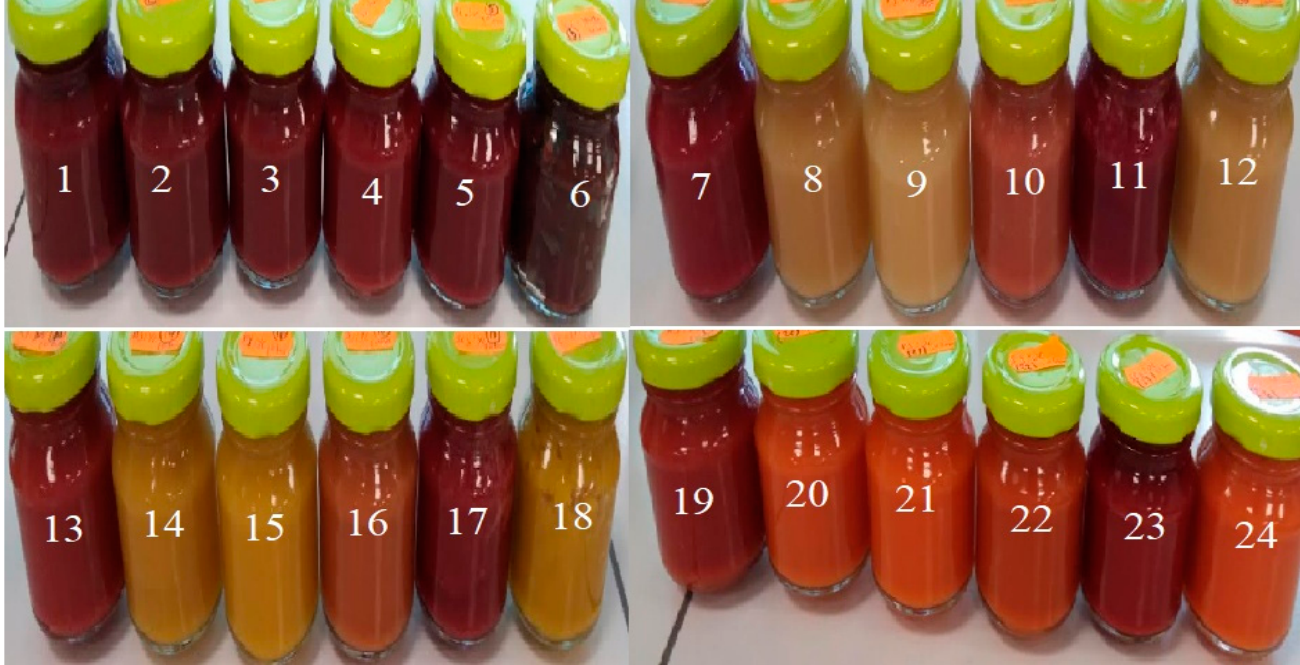
Figure 1. Prepared carrot blended smoothies (1, raspberry juice with purple carrot puree (RJ–PC); 2, apple juice with purple carrot puree (AJ–PC); 3, pear juice with purple carrot puree (PJ–PC); 4, strawberry juice with purple carrot puree (SJ–PC); 5, sour cherry juice with purple carrot puree (SCJ–PC); 6, purple carrot puree %100 (PC%100); 7, raspberry juice with white carrot puree (RJ–WC); 8, apple juice with white carrot puree (AJ–WC); 9, pear juice with white carrot puree (PJ–WC); 10, strawberry juice with white carrot puree (SJ–WC); 11, sour cherry juice with white carrot puree (SCJ–WC); 12, white carrot puree %100 (WC%100); 13, raspberry juice with yellow carrot puree (RJ–YC); 14, apple juice with yellow carrot puree (AJ–YC); 15, pear juice with yellow carrot puree (PJ–YC); 16, strawberry juice with yellow carrot puree (SJ–YC); 17, sour cherry juice with yellow carrot puree (SCJ–YC); 18, yellow carrot puree %100 (YC%100); 19, raspberry juice with orange carrot puree (RJ–OC); 20, apple juice with orange carrot puree (AJ–OC); 21, pear juice with orange carrot puree (PJ–OC); 22, strawberry juice with orange carrot puree (SJ–OC); 23, sour cherry juice with orange carrot puree (SCJ–OC); 24, orange carrot puree %100 (OC%100)).